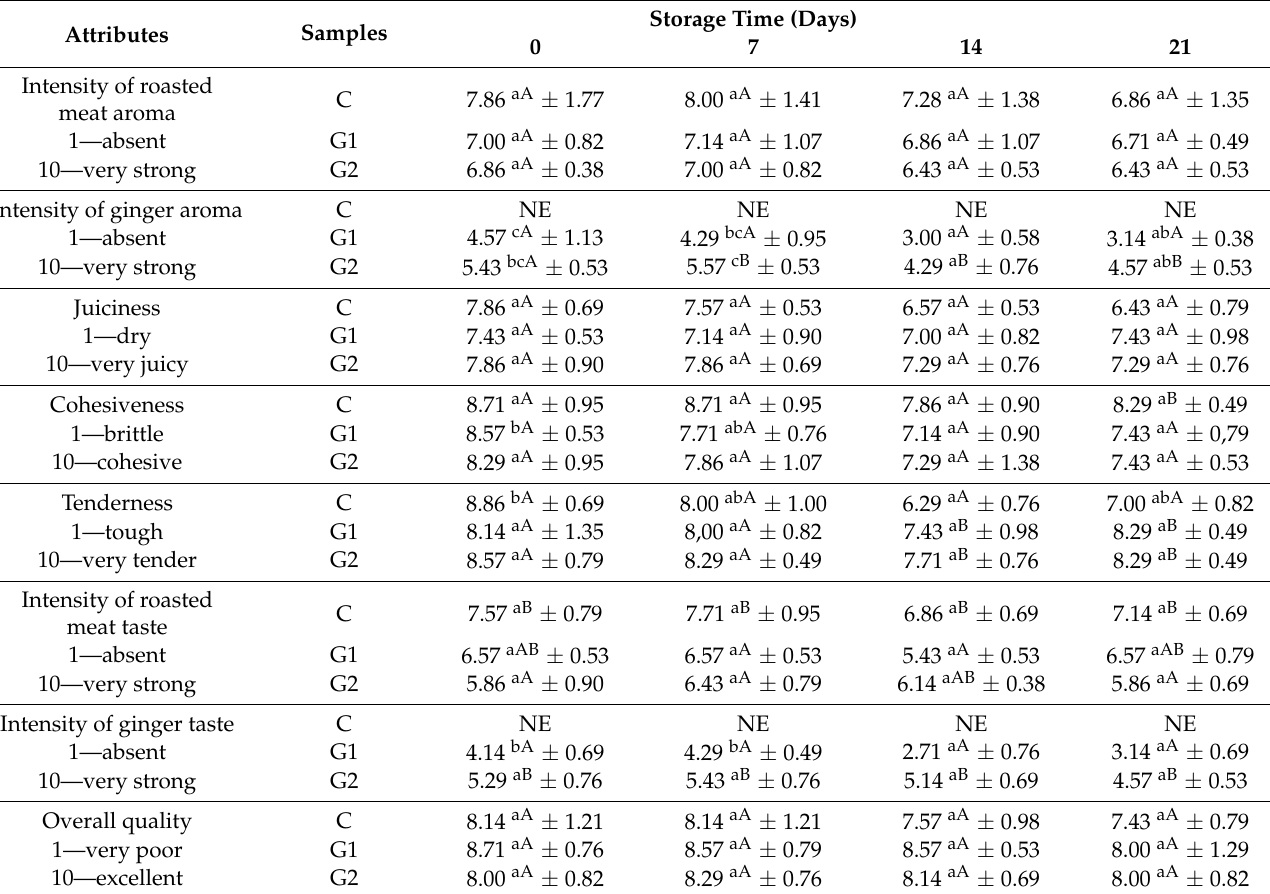
Table 5. The effect of ginger rhizome and storage time on the sensory quality of pork